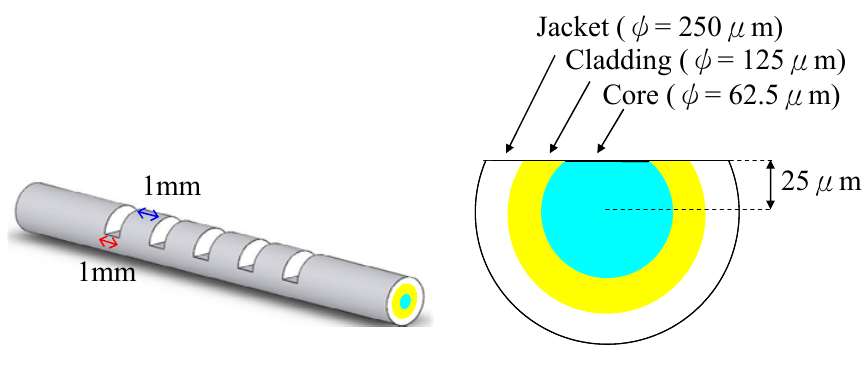
Figure 1 . Illustration diagram of the multi-D-shaped optical